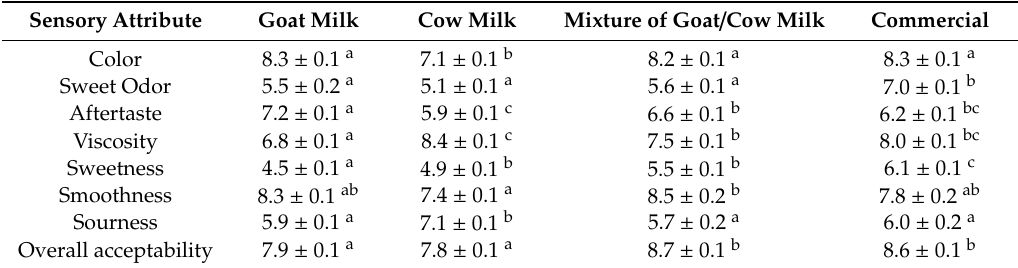
Table 6. Sensory evaluation of fermented milk produced using goat and cow milk and their mixture in comparison with commercial